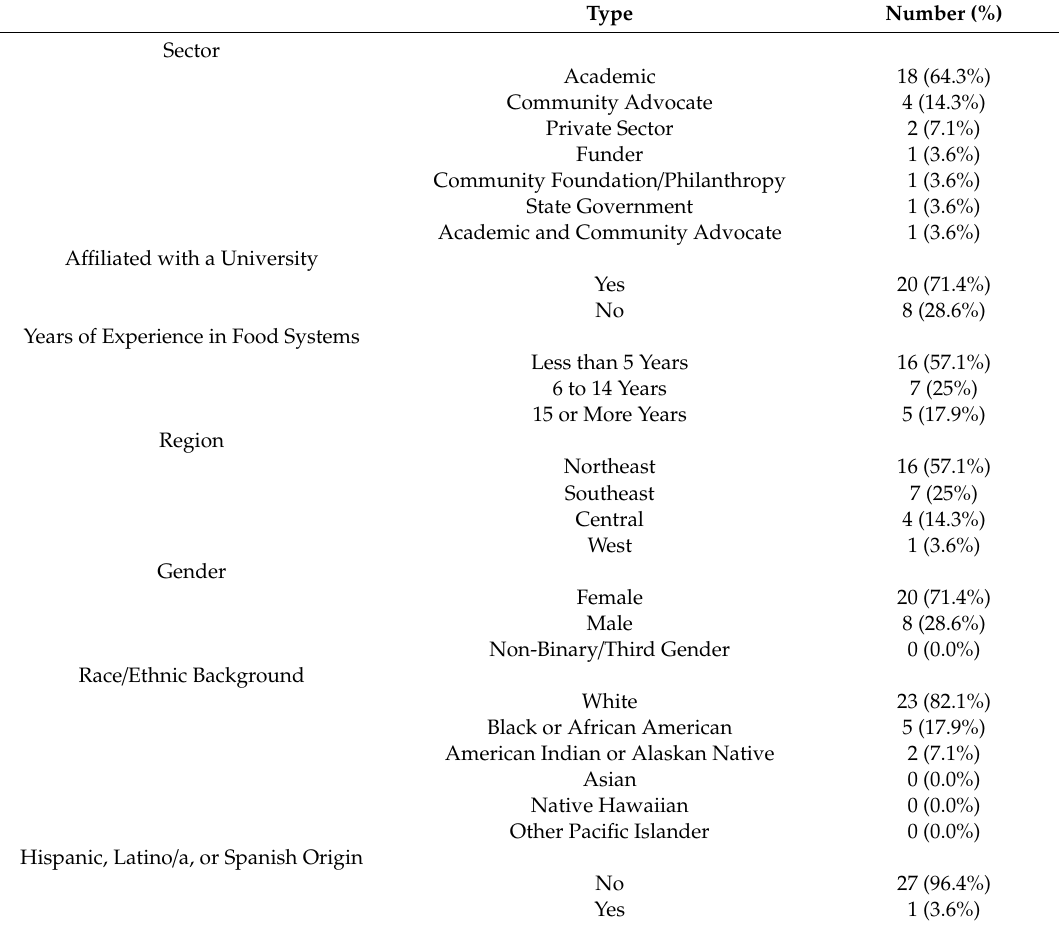
Table 1. Food System Expert